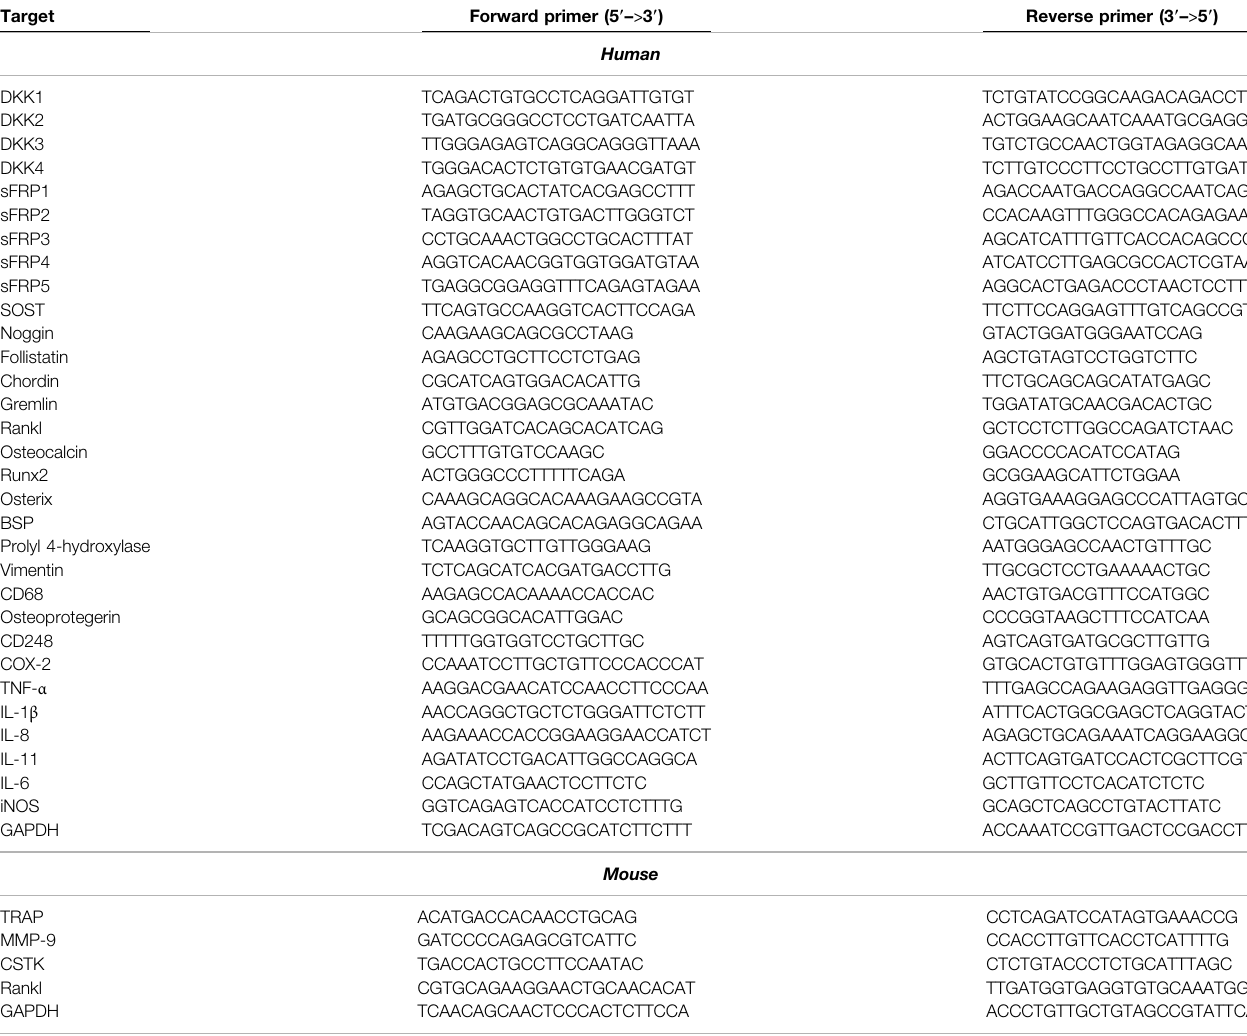
TABLE 1 | Primers for real-time